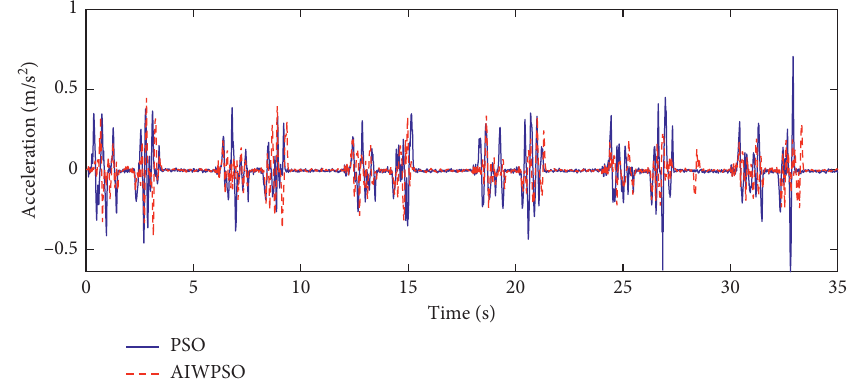
Figure 22: Vehicle body acceleration for a bumpy road